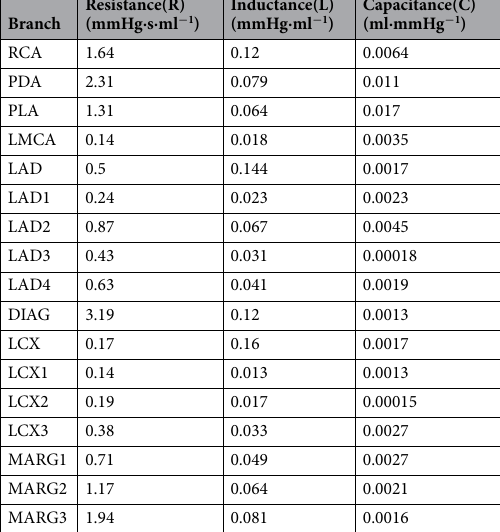
Table 1. Parameters of the patient-specific coronary model estimated from the CT data.